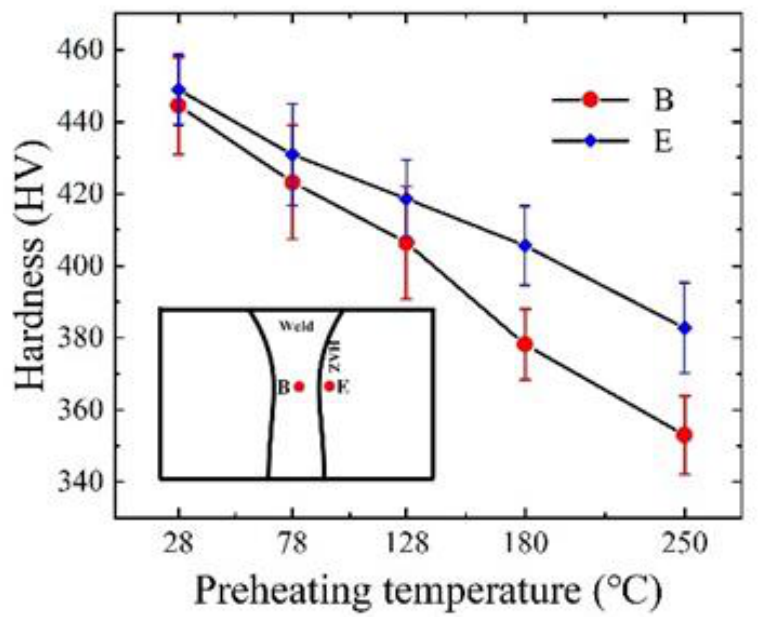
Figure 13. Microhardness at feature points B and E.